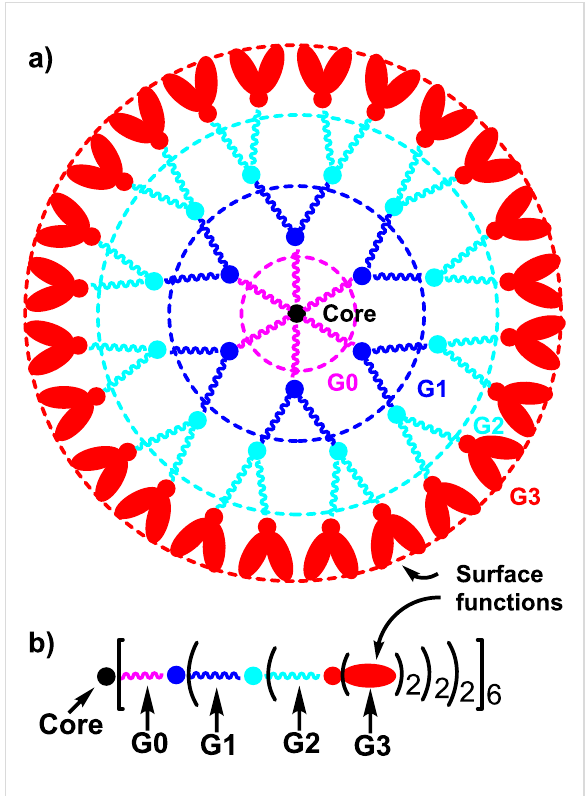
Figure 2: Two ways to represent schematized structures of dendrimers, showing the different generations (layers); a) full structure; b) linear structure with parentheses at each generation; multiplying the numbers associated with the parentheses gives the number of termi- nal functions (48 in the case of the third